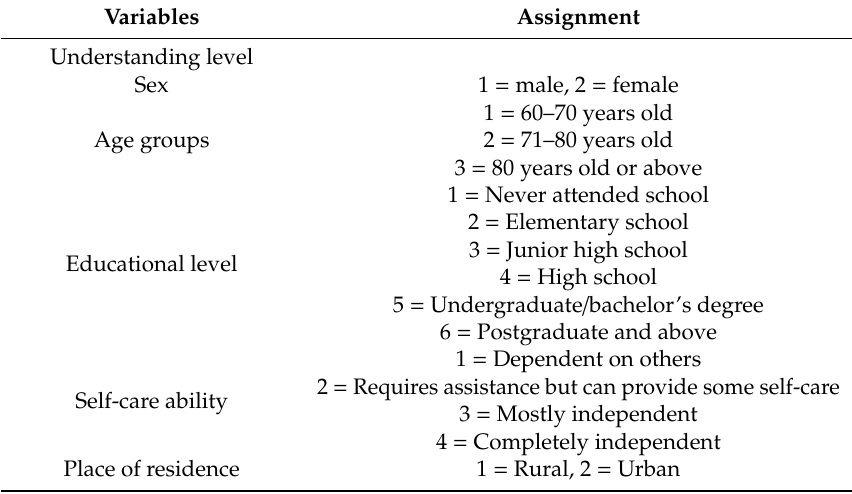
Table 6. Linear regression analysis variable assignment for the understanding of coronavirus disease 2019 (COVID-19) among the elderly individuals.